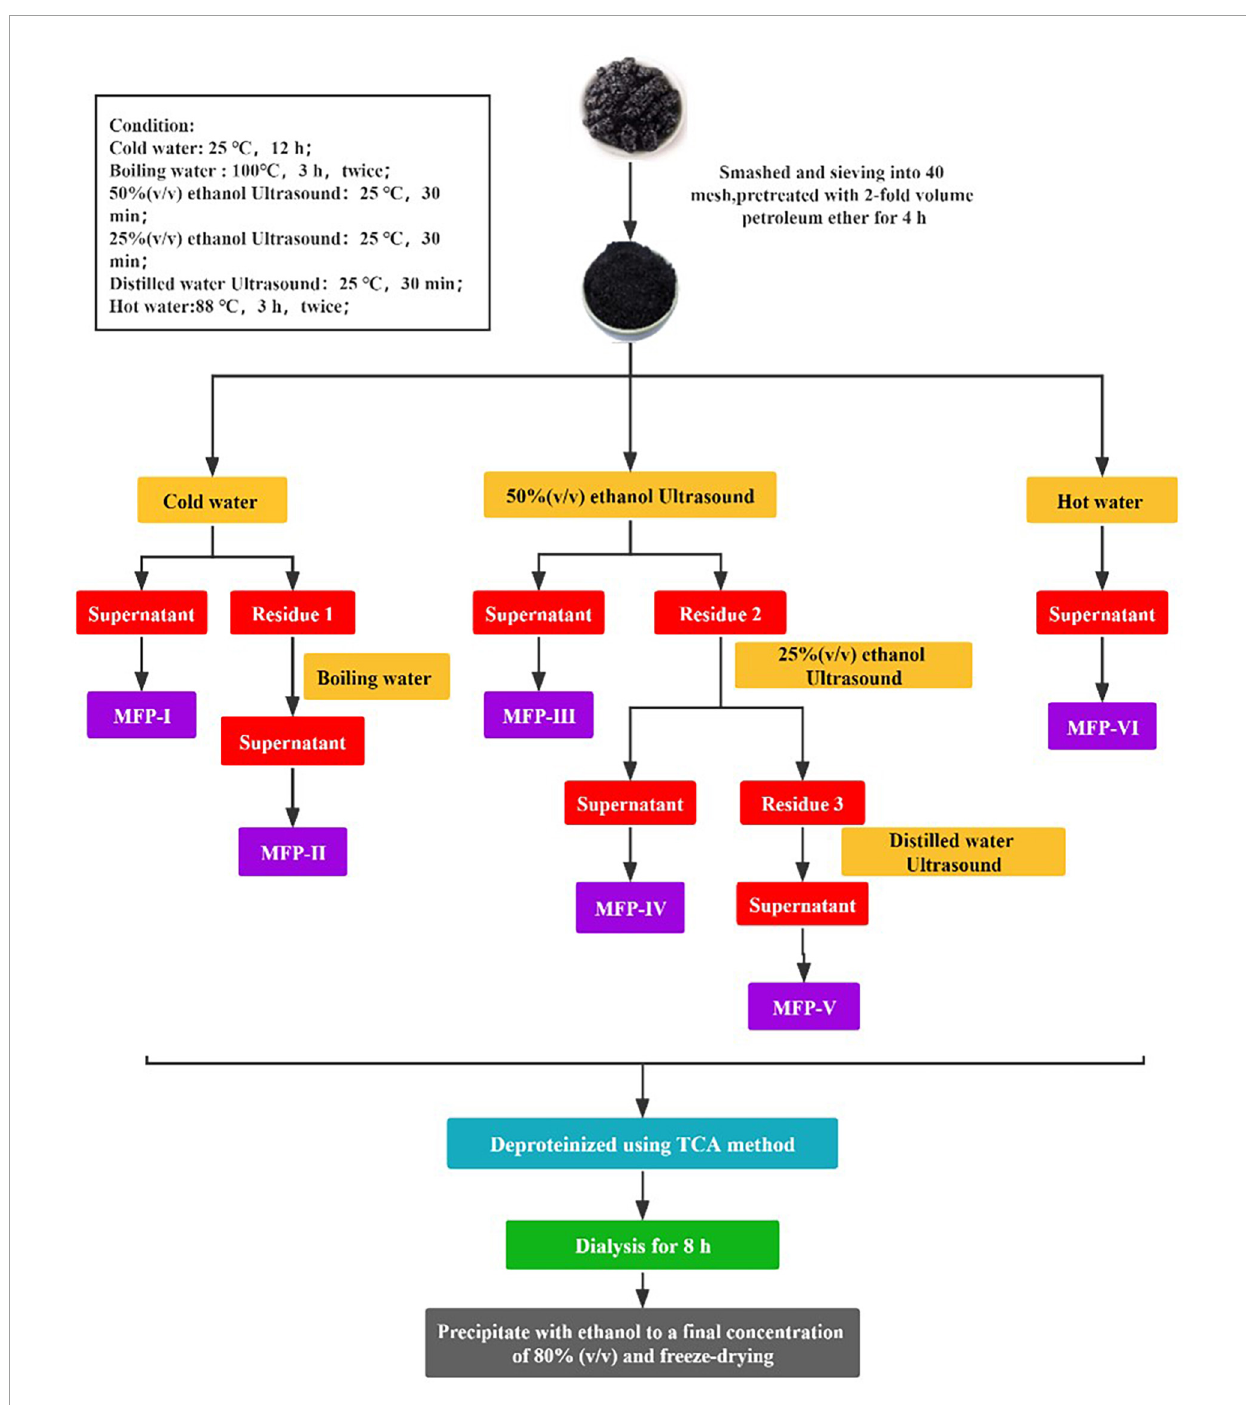
FIGURE2 Different extraction methods of mulberry polysaccharides.